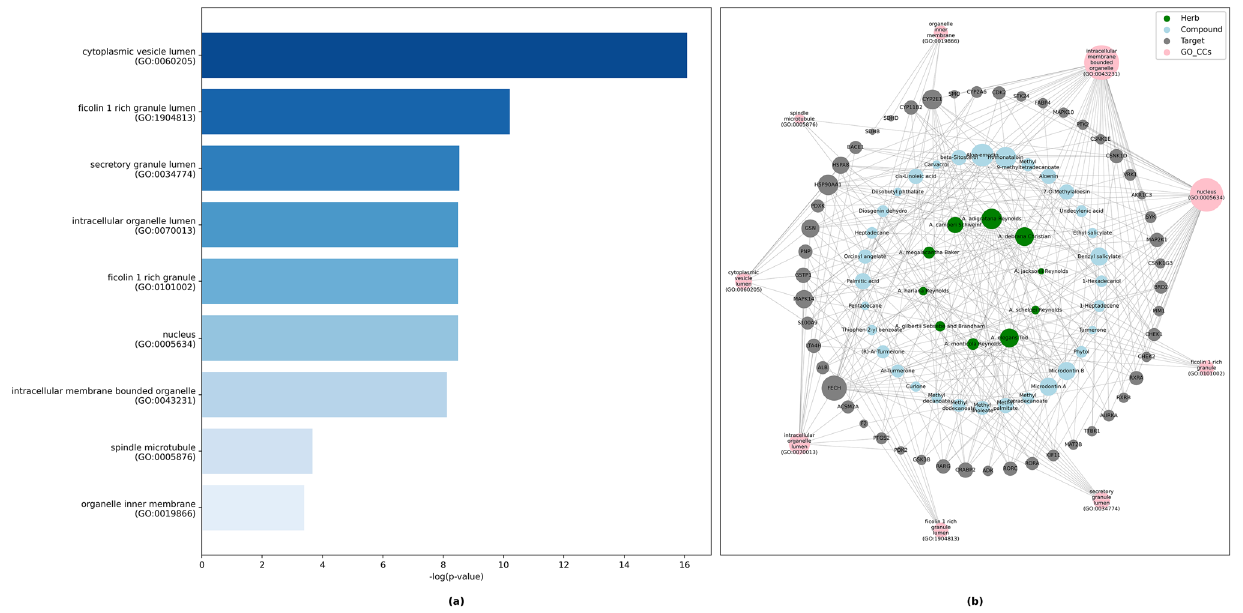
Figure 4. ( a ) Bar graph of KEGG analysis for top 20 enriched cellular components. ( b ) Phytochemical-target- cellular components network constructed by python NetworkX library illustrated pathways and their associated genes (Adjusted P ≤